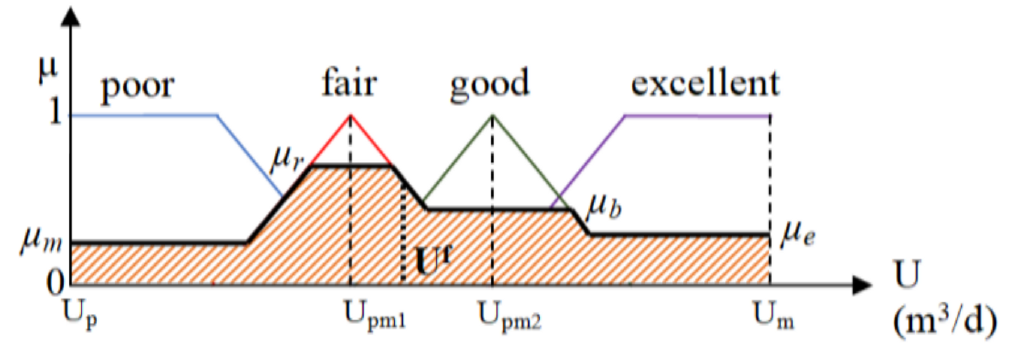
Figure 9. Fuzzy sets for defuzzification.